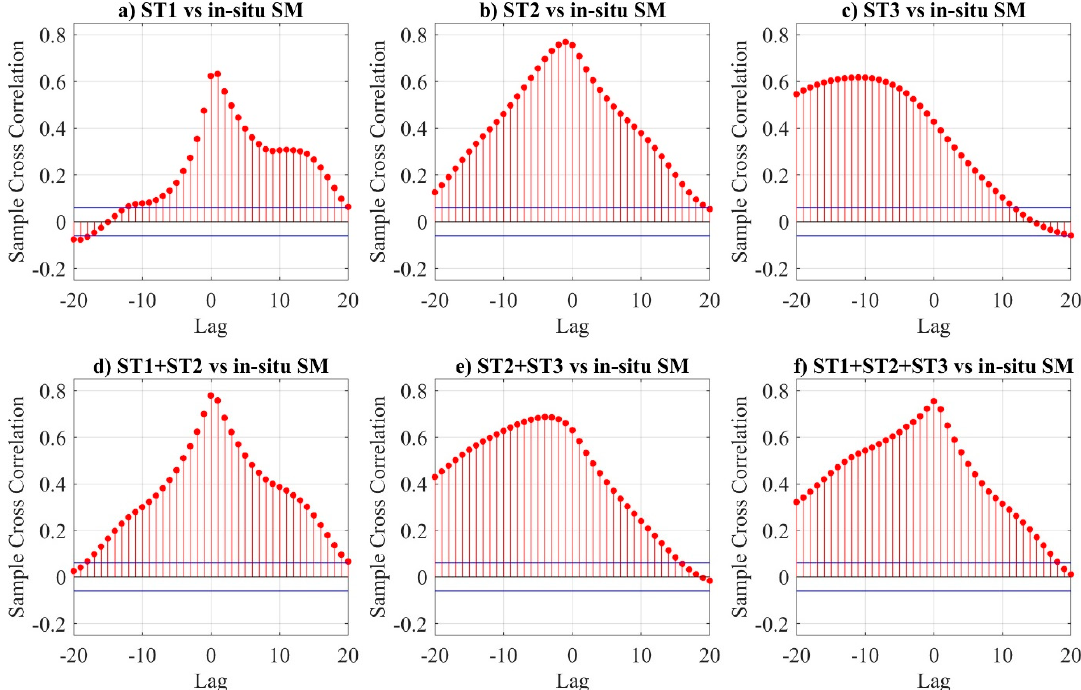
Figure 8. Lagged cross-correlation between the tank storage and in situ observations from 2014 to 2016. The solid blue line represents autocorrelation along with the 95% confidence interval for a white noise process. The values outside of the confidence interval are statistically significant.